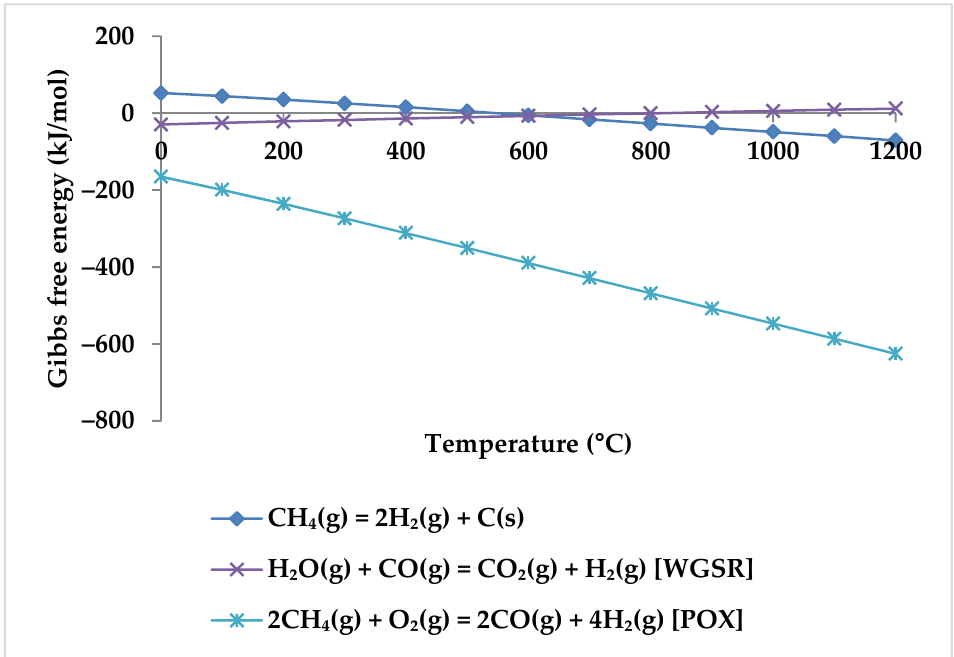
Figure 6. Gibbs free energy diagram for methane cracking, WGSR, and POX reaction. Lower reaction temperatures have a significant impact on the H 2 /CO molar ratios.